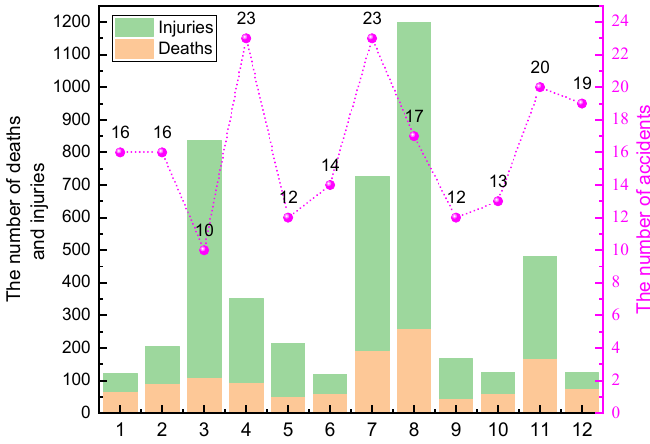
Figure 5. The number of HCA and casualties in different months from 2000 to 2020.